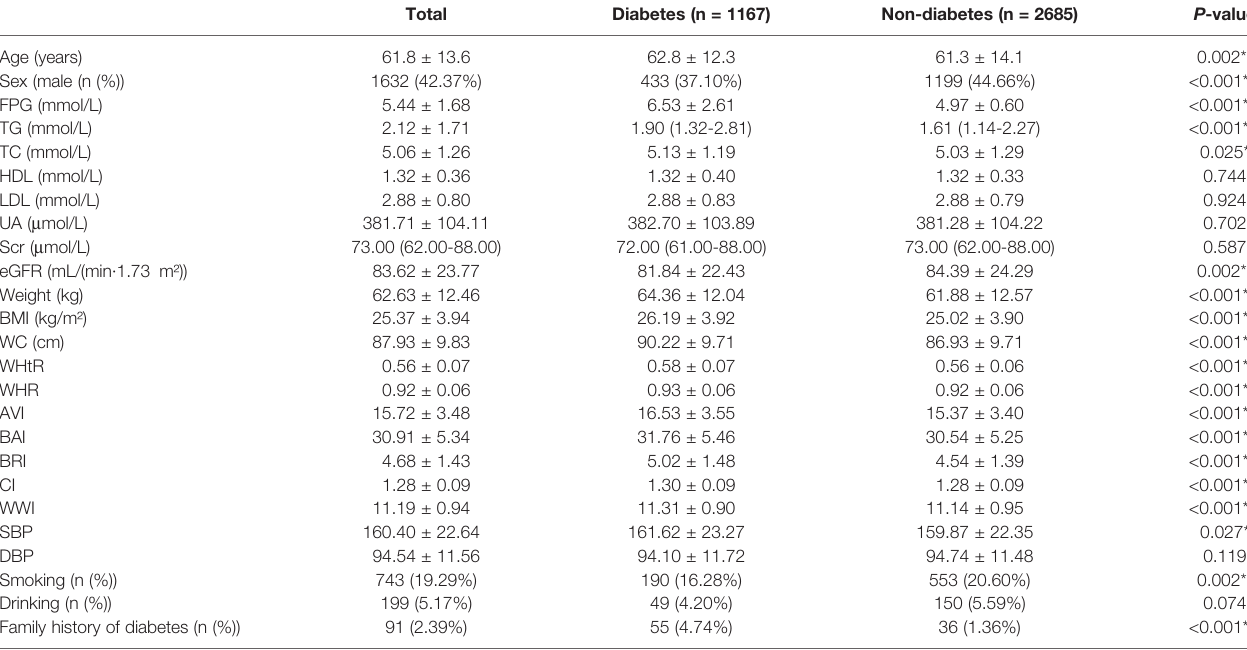
TABLE 1 | Baseline characteristics of subjects who did and didn't develop new-onset diabetes during follow-up.